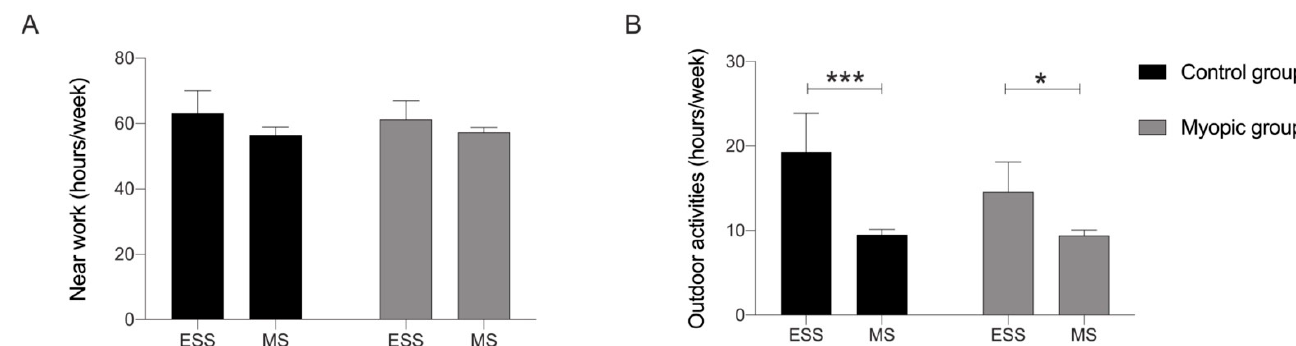
Figure 2. Comparison of environmental factors between the two cohorts of students. ( A ) Weekly hours of near work activities: analysis of control group vs. myopic group between environmental science and medical students. ( B ) Weekly hours of outdoor activities: analysis of control group vs. myopic group between environmental science and medical students. ESS: environmental science students; MS: medical students. Control group (>1.00 D); Myopic group ( ≤ 1.00 D). Significance p < 0.05. * p < 0.05, *** p <